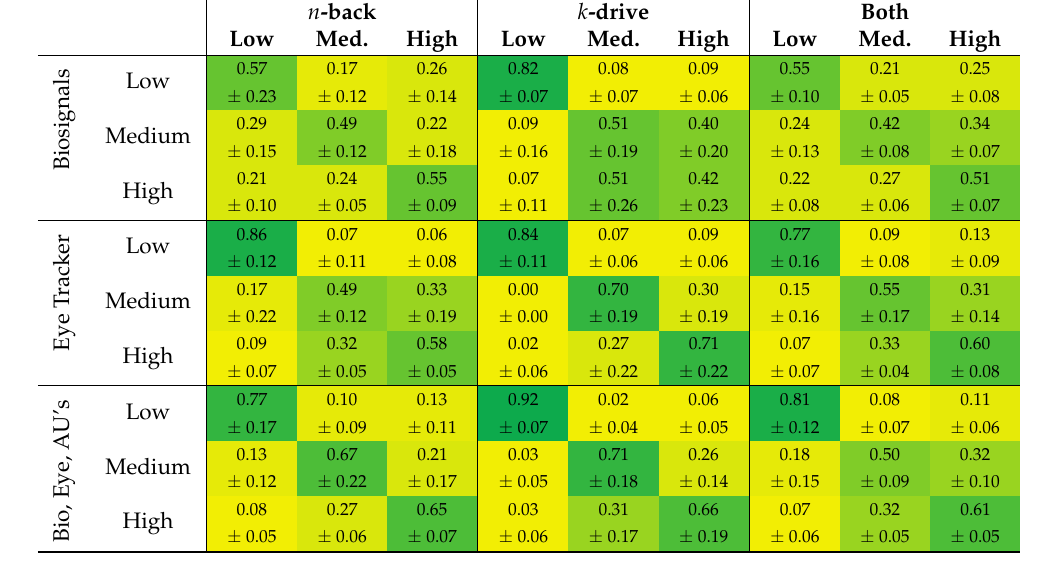
Table 9. Results of three-level-intensity classification tasks, treating different levels as separate classes (columns). For three different combinations of features, based on biosignals alone, only eye-tracker data and the combination of features based on multiple modalities: biosignals, eye-tracker-based action units (rows). We report the confusion matrix for the conducted experiments, using only n -back levels, only Drive levels and a combination of both experiments. The grouping of different phases for all experiments is described in Section 2.13. The rows correspond to the true class. n -back k -drive Both Low Med. High Low Med. High Low Med. High